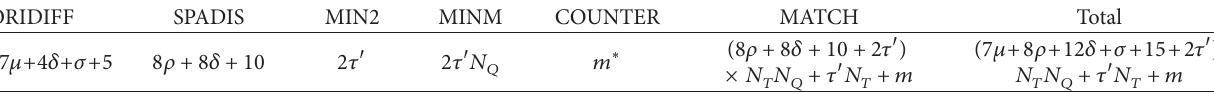
Table 4: Number of non-XOR gates in circuit for city block distance.